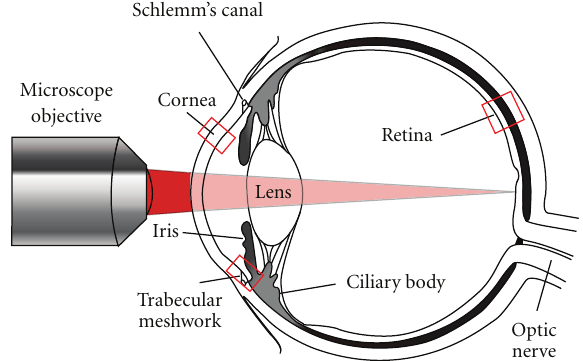
Figure 5: Schematic of the eye highlighting the regions of interest for imaging with multiphoton microscopy. Light path for imaging of the retina through the anterior chamber and lens is